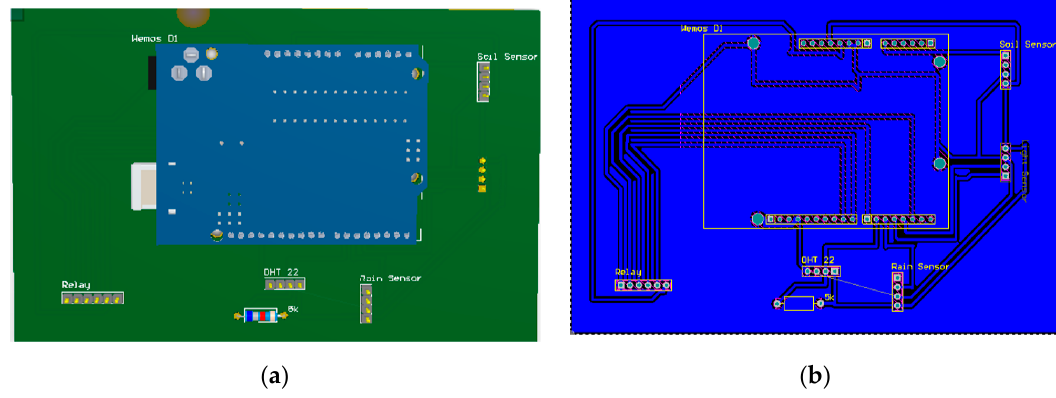
Figure 7. PCB design ( a ) and layout design ( b ) for the interface basement module.